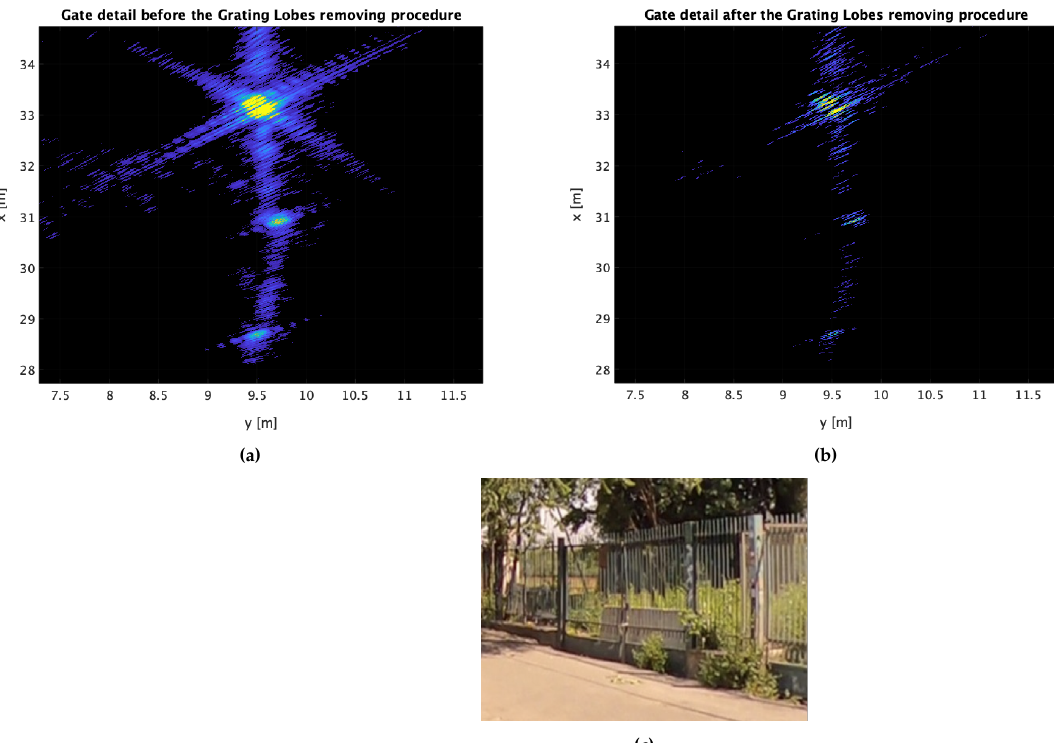
Figure 10. (a): SAR image of a gate detail before the grating lobes suppressing algorithm. (b): SAR